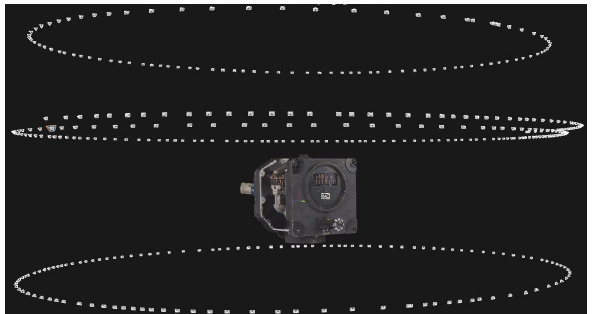
Figure 4. Photogrammetric 3D surface model of Figure